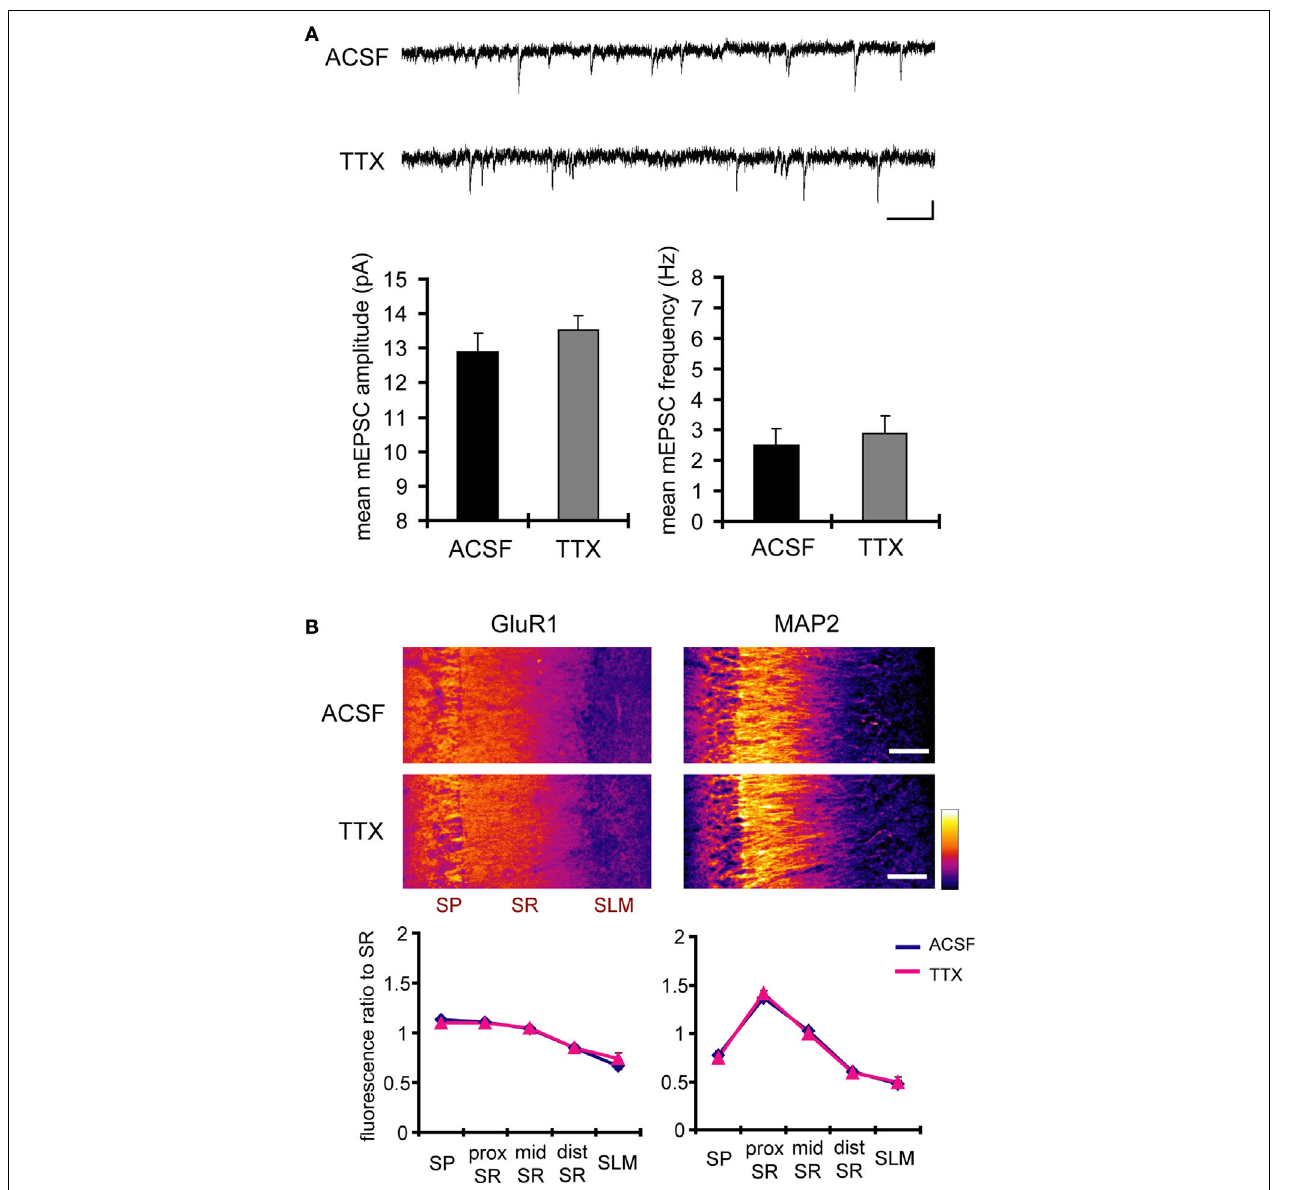
FIGURE 6 | A 12-h treatment with TTX alone infl uenced neither mEPSC frequency/amplitude nor GluR1 distribution. (A) Representative mEPSCs recorded from the somata of CA1 pyramidal neurons. Hippocampal slices were treated either with or without TTX (2 µM) for 12 h. The TTX-treatment alone infl uenced neither the amplitude nor the frequency of mEPSCs ( n = 9 for each